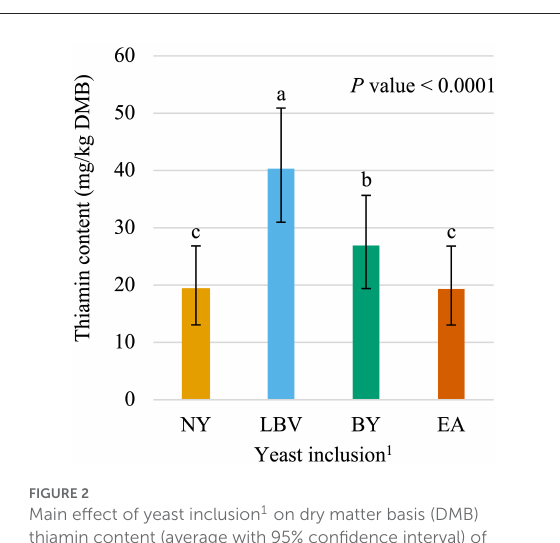
FIGURE2 Main effect of yeast inclusion 1 on dry matter basis (DMB) thiamin content (average with 95% confidence interval)